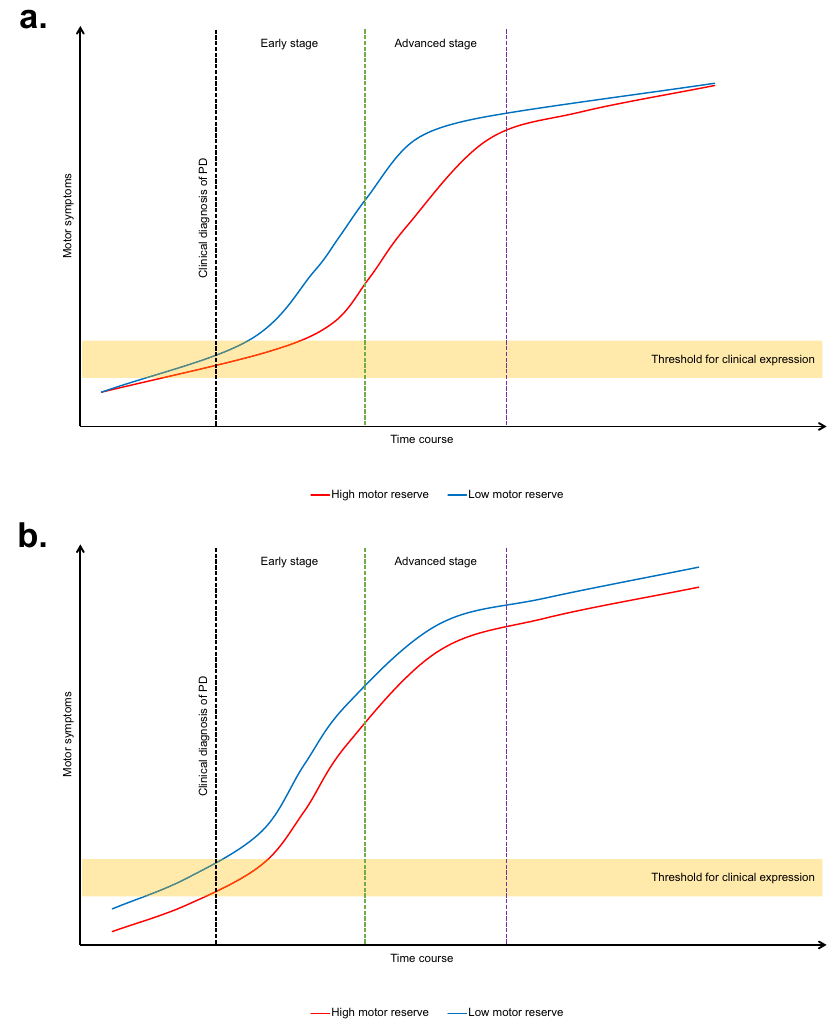
Fig. 4 Two possible mechanisms of motor reserve in Parkinson ’ s disease. a An active motor reserve hypothesis shows that the rate of motor symptom progression is different according to the disease stage. b In contrast, a passive motor reserve model shows the progression rate of motor symptoms is not affected by the disease